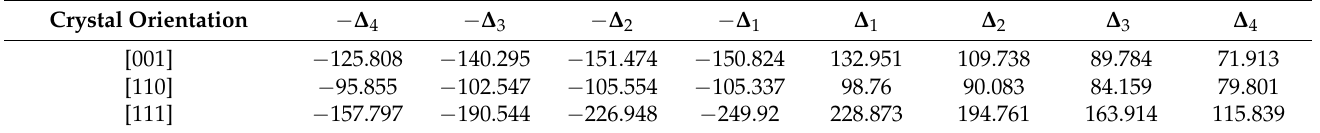
Figure 12. Variation curves of lattice thermal conductivity of diamond in the [001], [110] and [111] crystallographic directions after positive and negative electric fields are applied (temperature range is 240 − 500 K). ( a ) The positive and negative electric fields are applied to the [001] crystallographic direction; ( b ) the positive and negative electric fields are applied to the [110] crystallographic direction; and ( c ) the positive and negative electric fields are applied to the [111] crystallographic direction. Table 3. The rate of change of lattice thermal conductivity after applying an electric field in diamond [001], [110] and [111] crystal orientations. ( T = 300